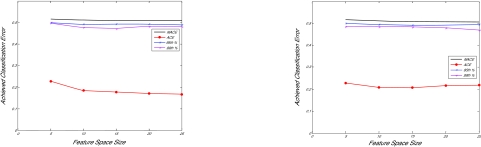
PACE analysis using a SVM-based classifier using the J5 scoring criterion, with a 0.6 MAC threshold. Left Panel: performance without peak selection. Right panel: performance with peak selection.